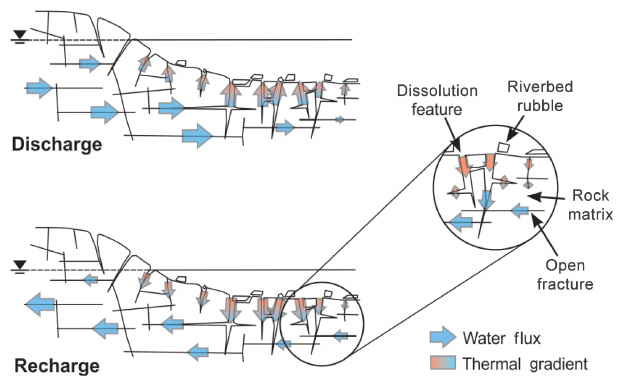
Figure 1. General conceptual model of the groundwater flow sys- tem beneath a fractured bedrock river. Groundwater–surface water mixing is controlled by open fractures and dissolution-enhanced features, with secondary exchanges (flux or diffusion) occurring be- tween fractures and rock